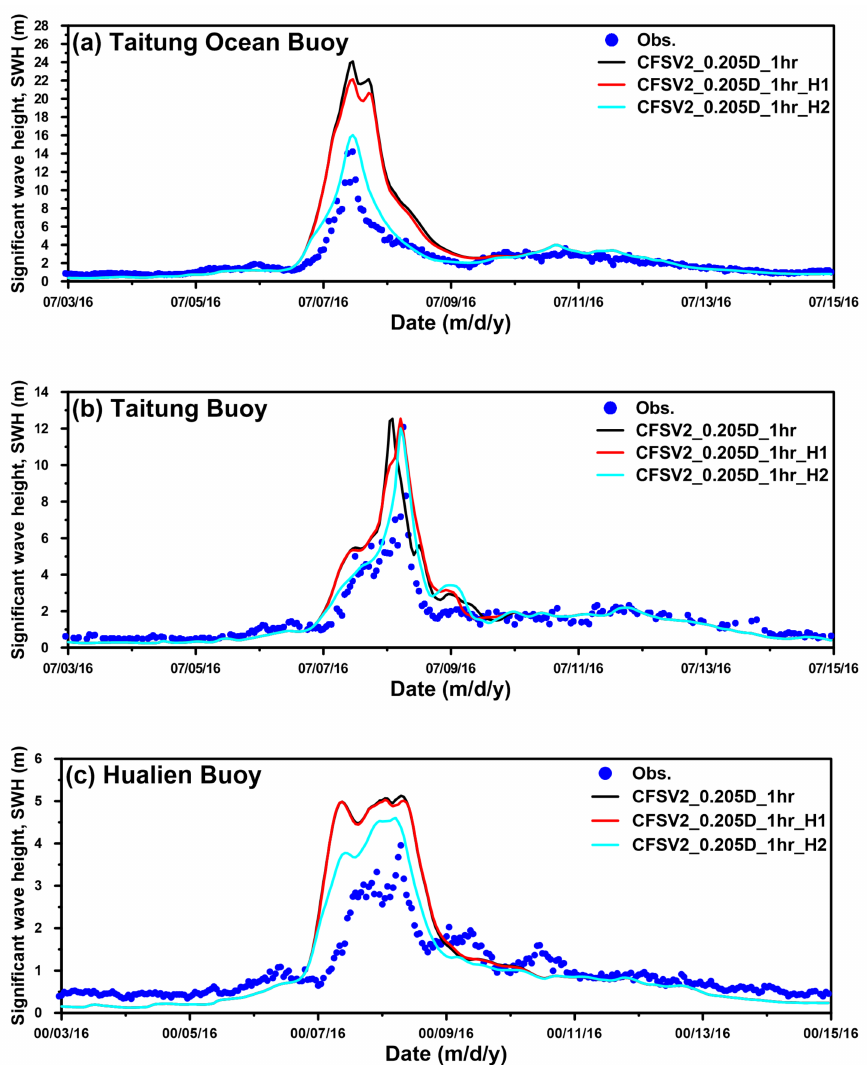
Figure 9. Model-data comparison for the SWH time series the ( a ) Taitung Ocean, ( b ) Taitung, and ( c ) Hualien buoys employing winds from CFSV2 with a spatial resolution of 0.205 ◦ ,